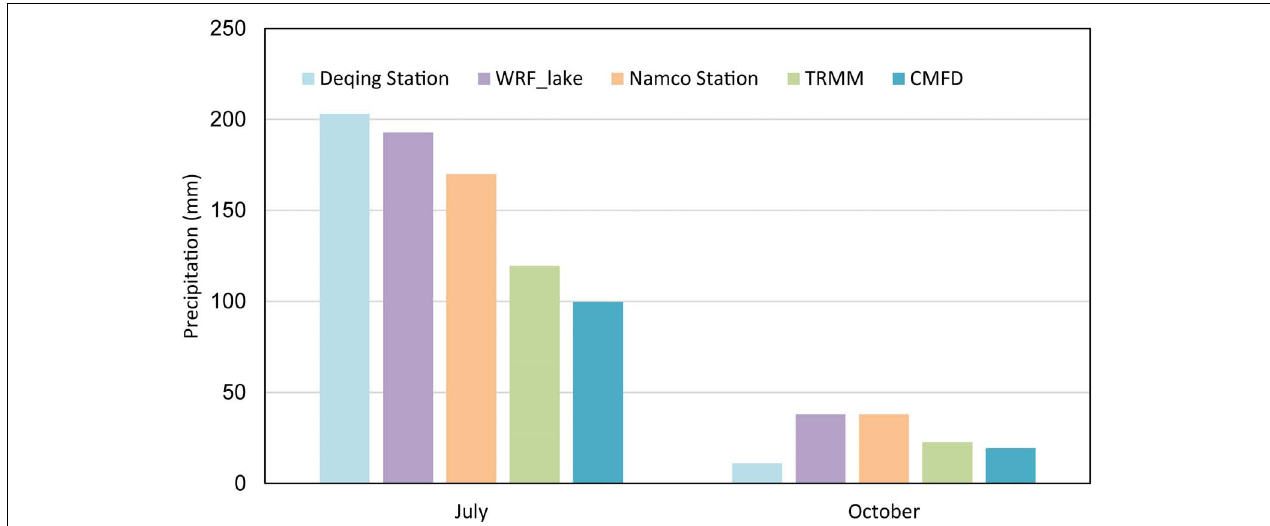
FIGURE 5 | The monthly precipitation at the upwind Deqing station (blue), and the downwind Nam Co station (orange), as well as the monthly precipitation averaged over the Nam Co Lake by the WRF simulation (purple) and from the TRMM product (green) and CMFD (dark blue), in July and October, respectively.